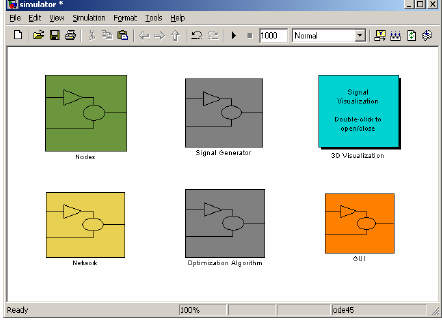
Figure 5. Main WSAN simulation platform interface.